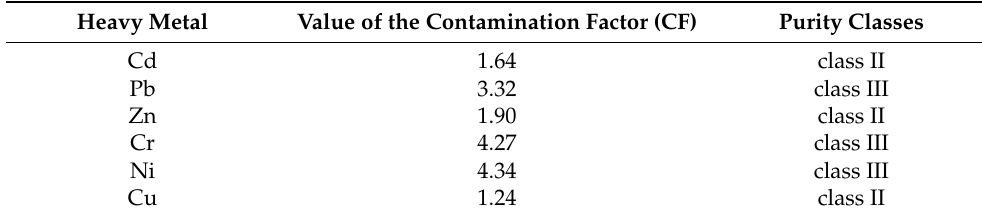
Table 10. The contamination factor (CF) and purity